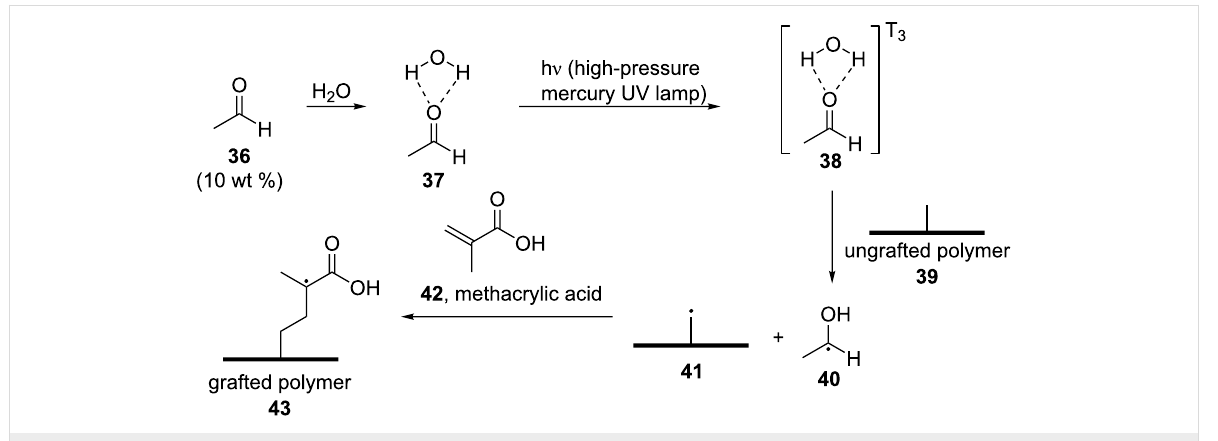
Scheme 11: Photografting by employing acetaldehyde ( 36 ) as the